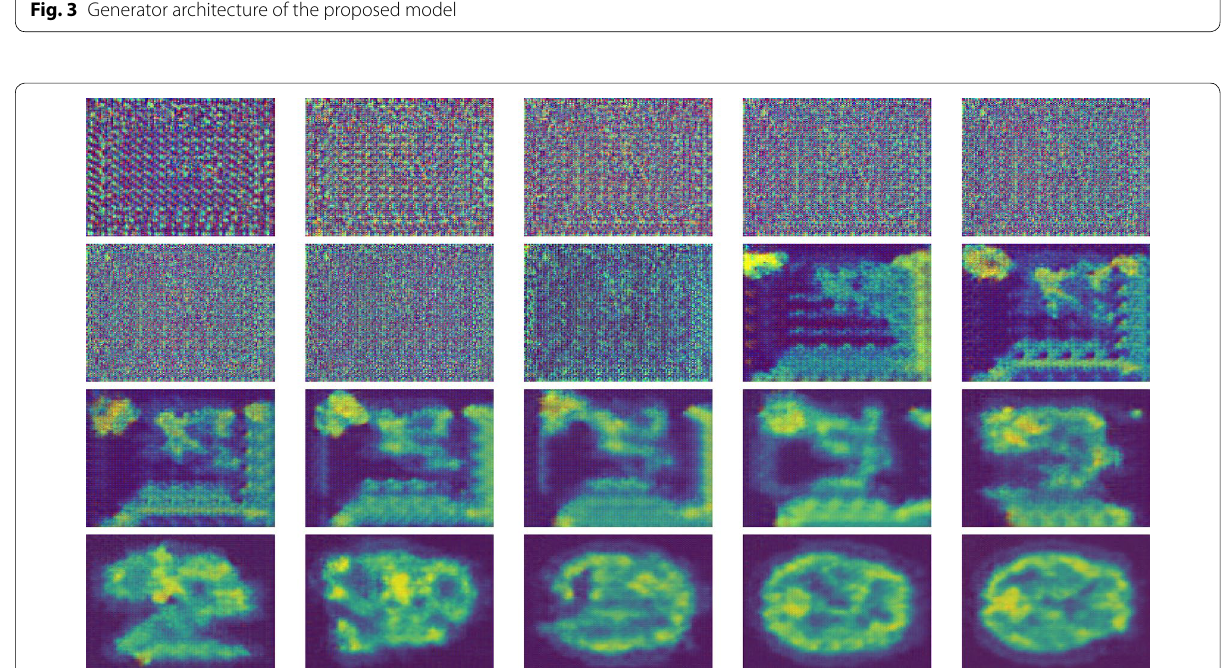
Fig. 4 Visualization of the generator output in the training